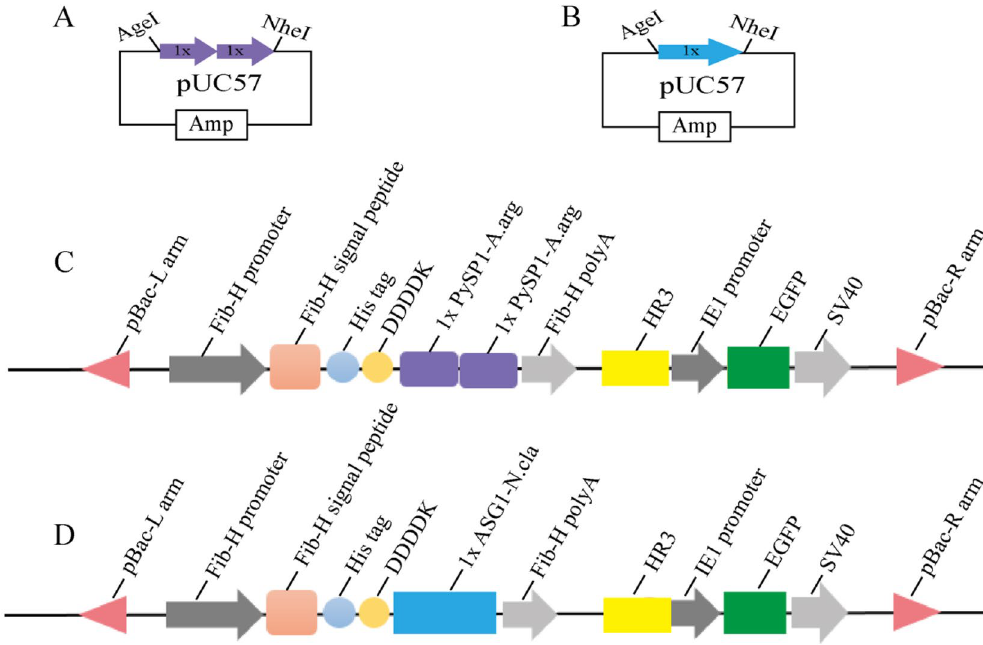
Figure 1. Structures of the intermediate vectors and donor vectors used in this study. ( A , B ) The intermediate vectors pUC-2xPA and pUC-1xASG1 carried AgeI and NheI, respectively. ( C , D ) Donor vectors pBac[IE1- EGFP]-2 × PySp 1-A.arg and pBac[IE1-EGFP]-1 × ASG 1-N.cla, respectively. The key elements are shown in different colors: purple represents one repeat of PySp 1 of A. argentata (234 aa), and blue shows one repeat of ASG 1 of T. clavipes (384 aa).